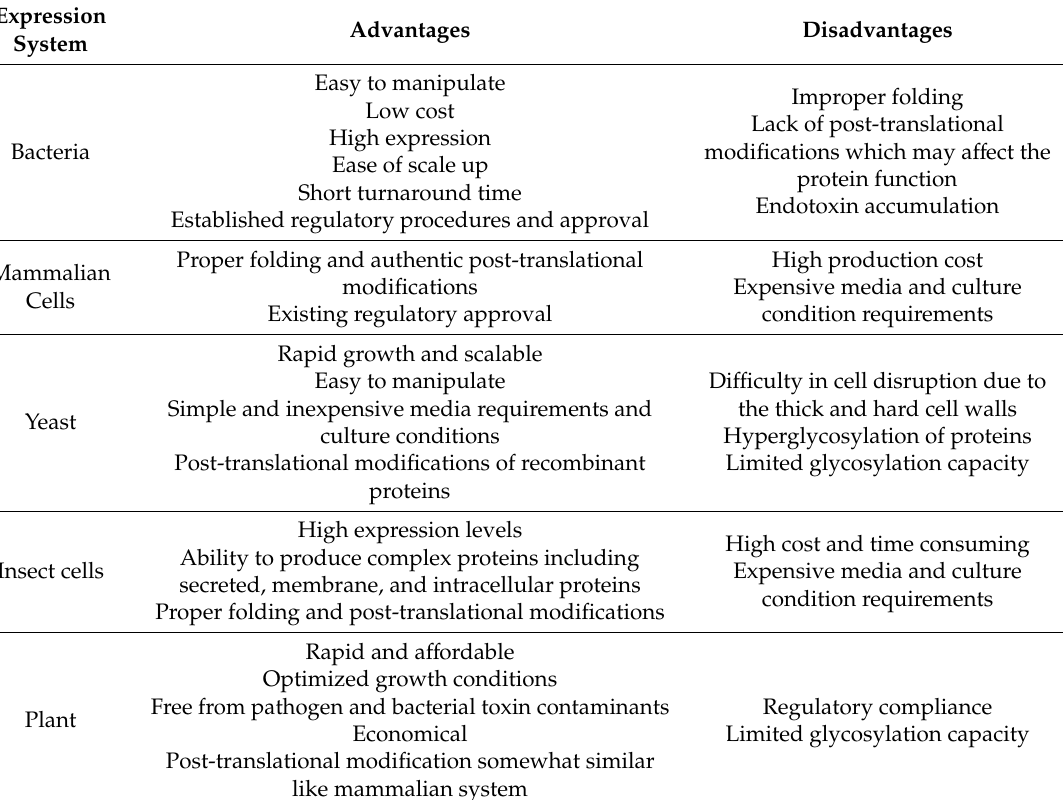
Table 1. Available expression platforms for recombinant protein production with potential advantages and disadvantages (adapted from Shanmugaraj et al., 2020)